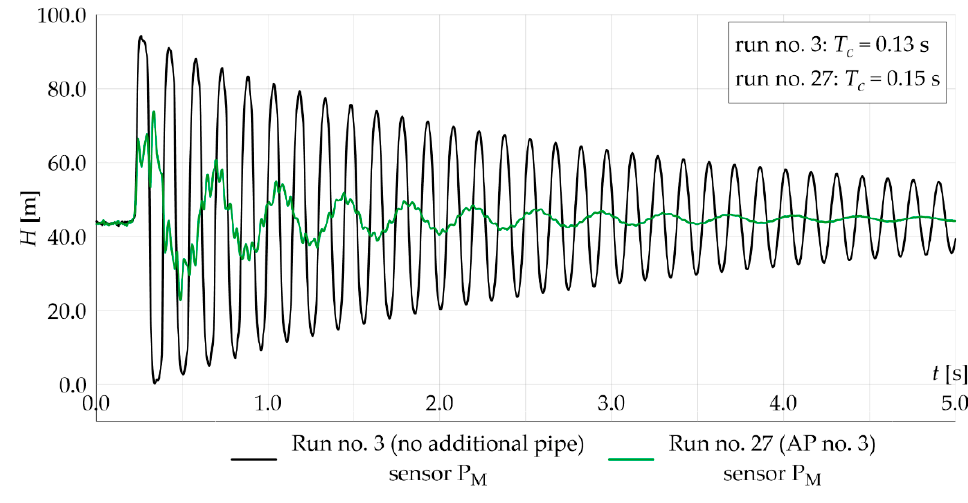
Figure 7. Pressure oscillations recorded during runs no. 3 and no. 27.